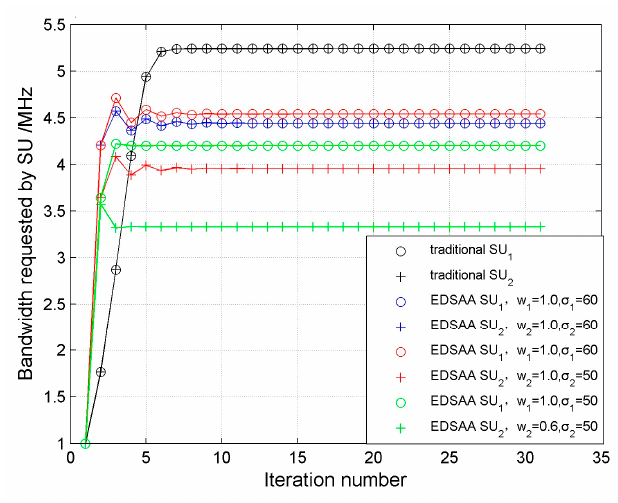
Figure 5. Iteration curve of the dynamic game of secondary user (SU).